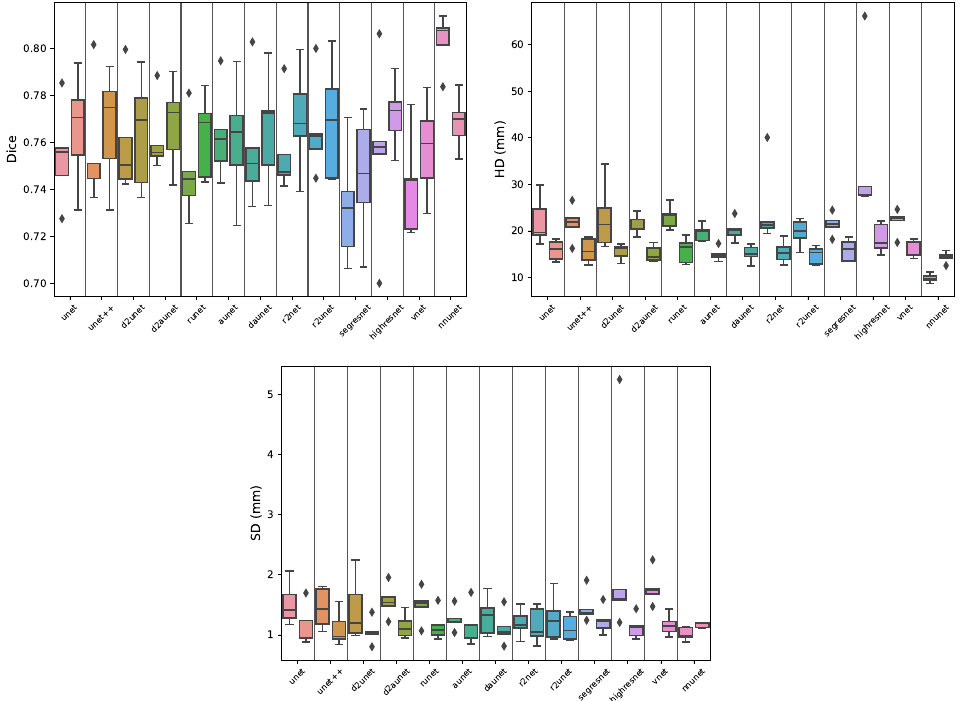
Figure 8. Boxplots showing the distribution of Dice, Hausdorff distance (HD) and Surface distance scores per model during cross-validation for the peripheral segmentation task. Each segment contains a pair of boxplots, where the left one corresponds to the results of the model on the full data, and the right one on the cropped